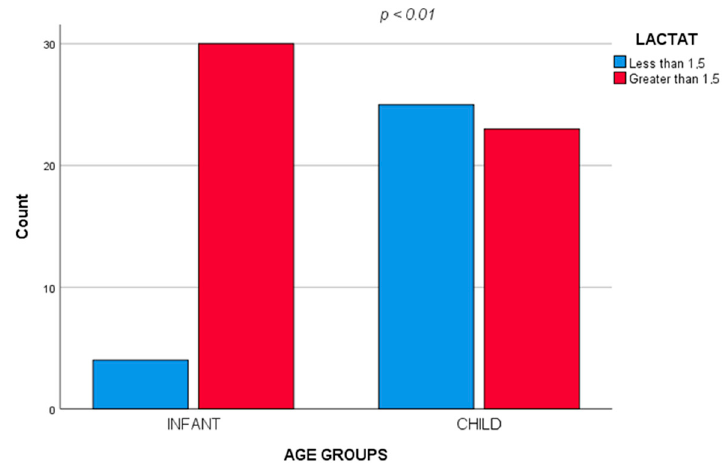
2); high levels of CPR were associated with the child group ( χ 2 = 4.952, p = 0.04).